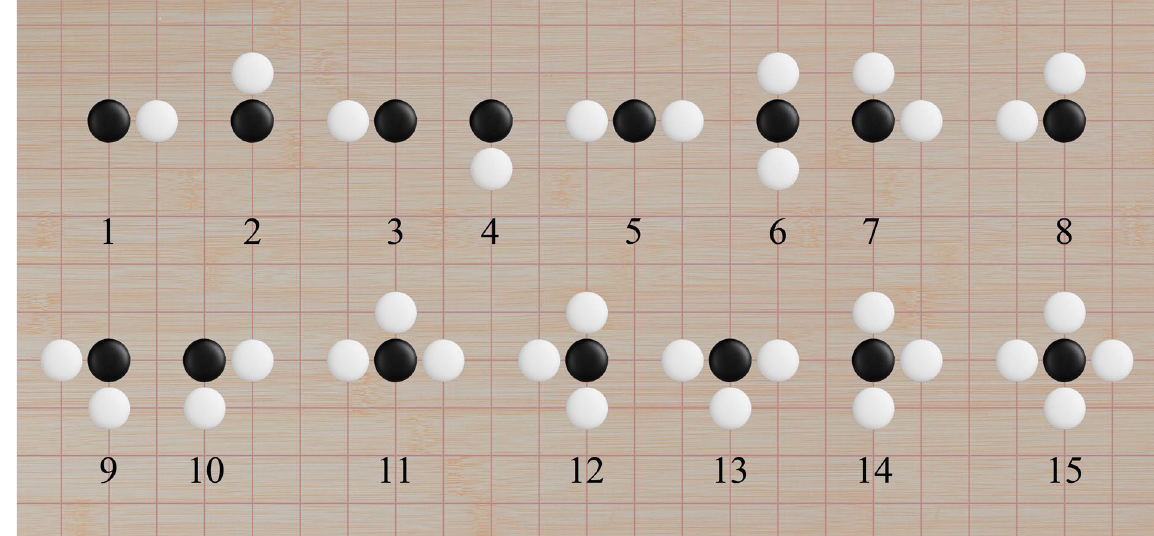
Figure 1. The fifteen possible vertex types appearing in a cluster on square lattice, as labeled by integers 1–15. The black stones denote the atoms of concern, while the white stones indicate the existence of possible nearest